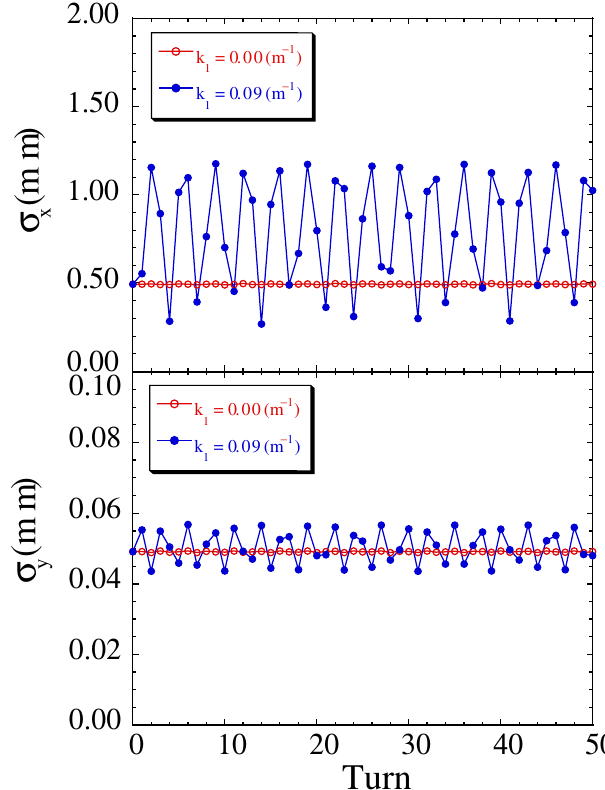
FIG. 13. (Color) Horizontal and vertical beam sizes, (cid:10) are represented as a function of the turn number. The closed and open circles show the beam sizes after a kick with the physical of 0 : 09 m (cid:5) 1 and without a kick ( k strength k 1 The beam sizes of the stored beam at the central location of the north long straight section without the kick, (cid:10) constant at 0.494 and 0.049 mm, respectively. (cid:10) by the PQM and varies from 0.3 to 1.2 mm, while (cid:10) varies from 0.047 to 0.053